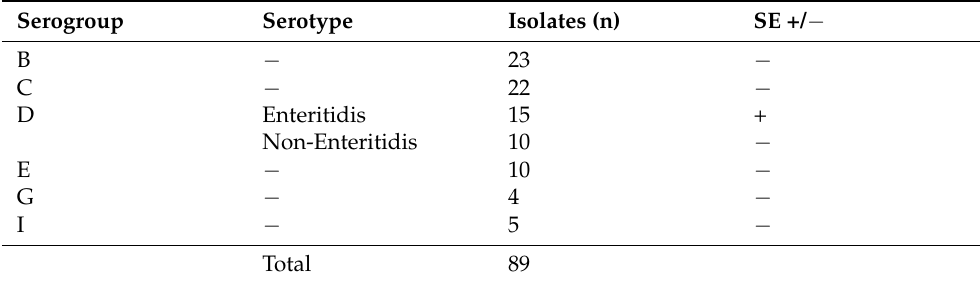
Table 1. Evaluation of the specificity of SE qPCR assay.